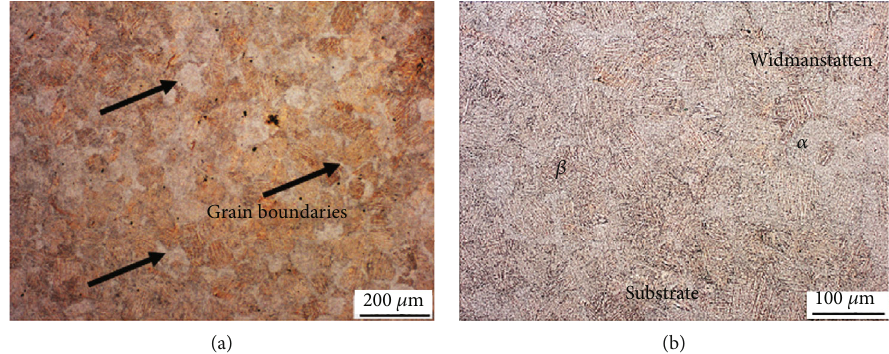
Figure 6: Microstructure of 3D-printed dental implant and formation of martensite structure in titanium material. (a) Grain boundaries. (b) Widmanstatten structures with α -phase and a β